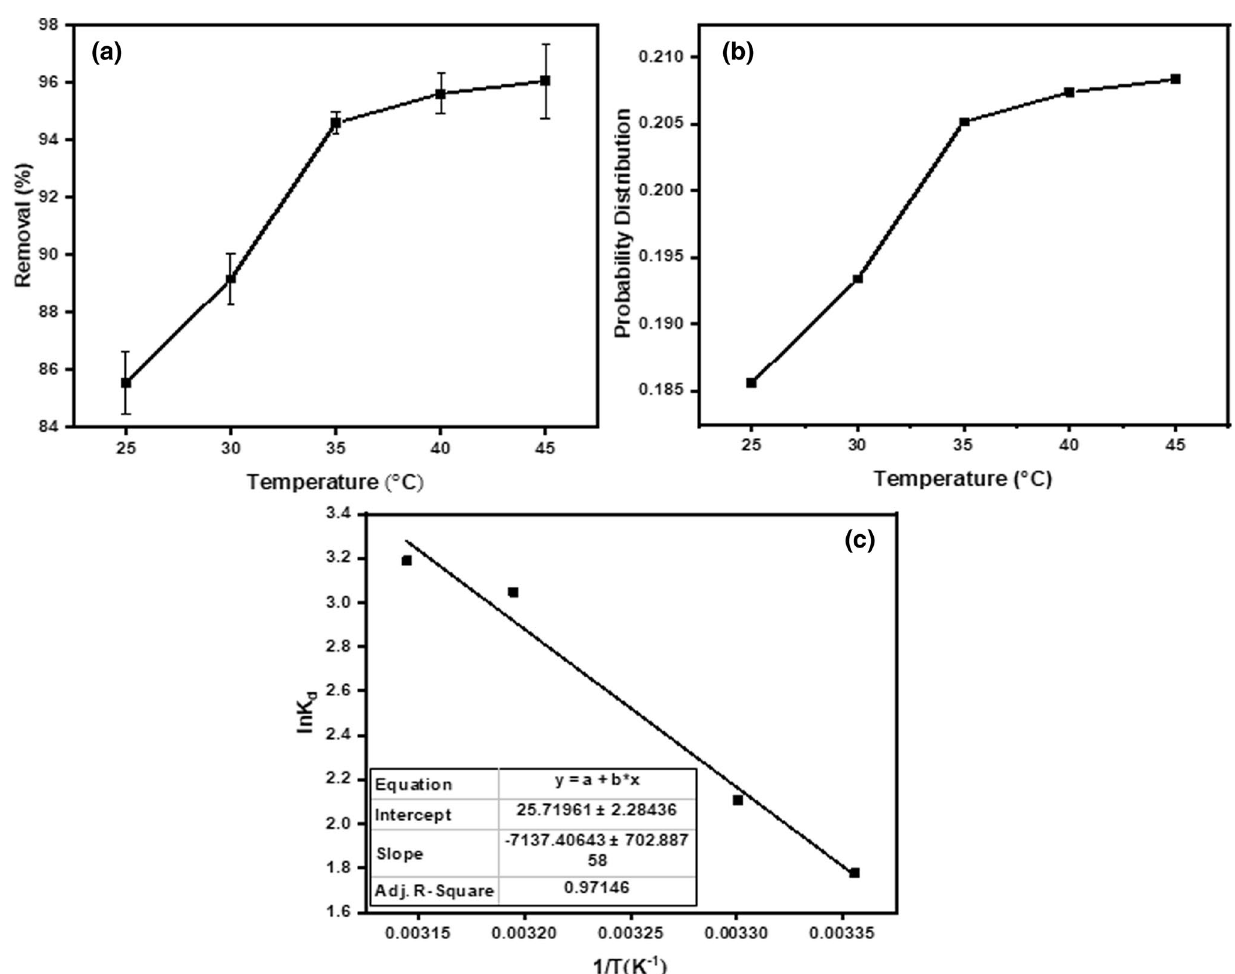
Fig. 10 a Effect of temperature on the percentage removal of As (III) by His-MMt b PDF of Temperature study c Van’t Hoff plot at 25 °C